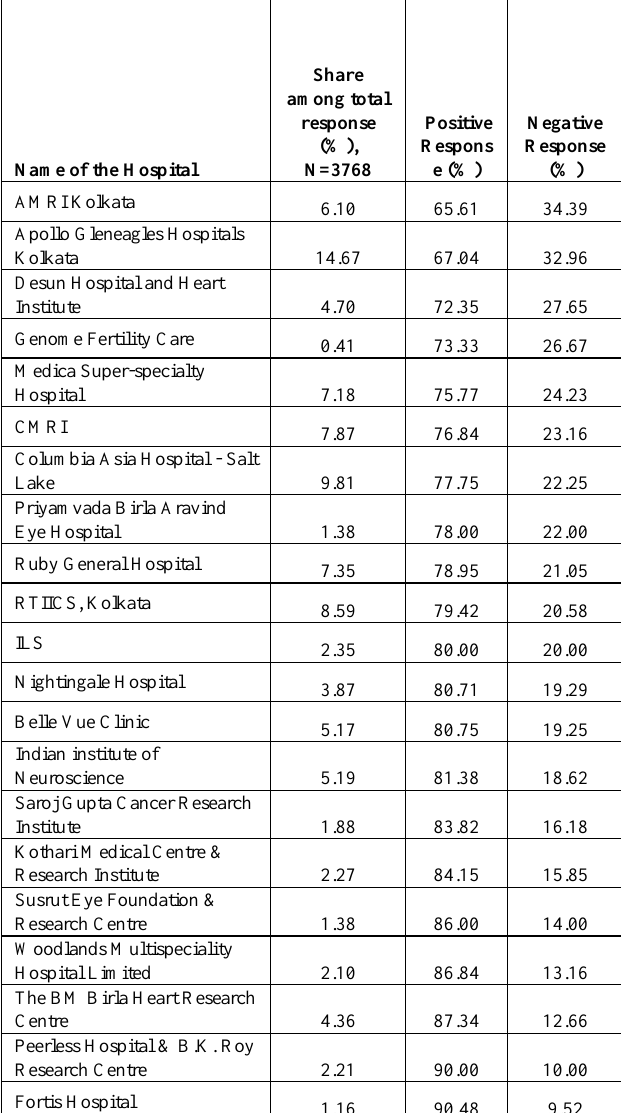
Table 3. Medical Treatment opted by local patients